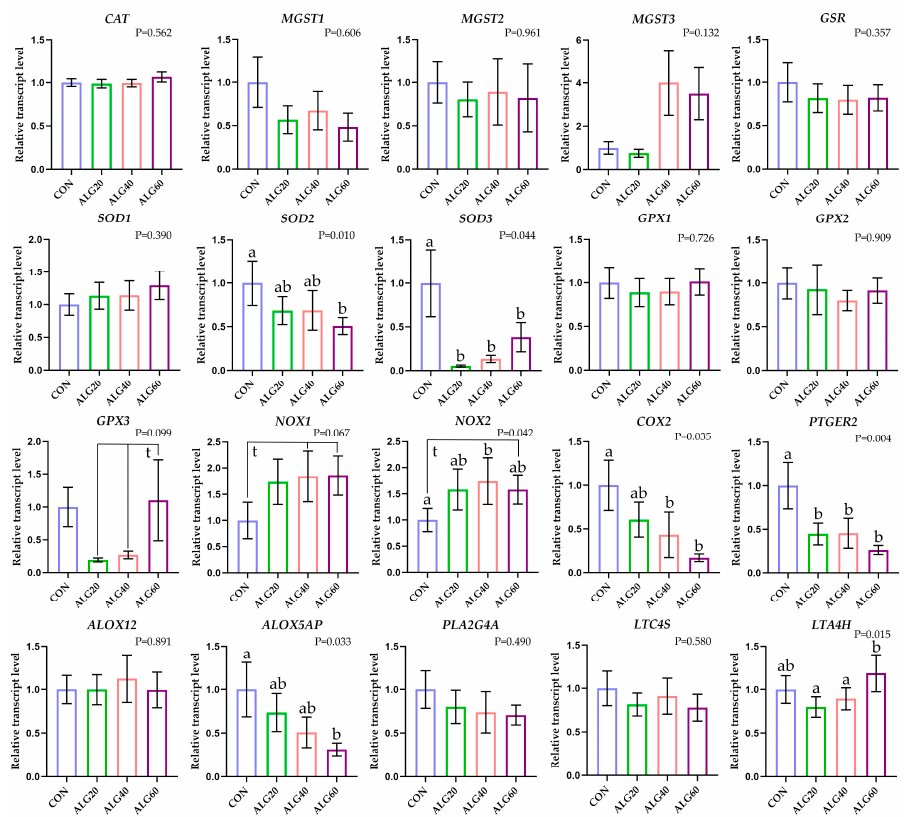
Figure 1. Mean and standard error (SE) of relative transcript levels as fold change of several anti- and pro-oxidant-related and immune-related gene expressions in monocytes of goats fed the four experimental diets (CON, ALG20, ALG40, and ALG60) at three sampling times (20th, 40th and 60th). Different superscript (a, b) between dietary treatments differ significantly ( p ≤ 0.05) while, t; trend refers to p < 0.10.